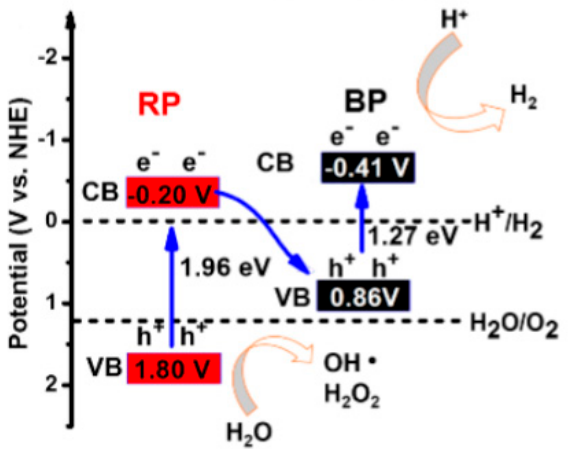
Figure 16. Schematic illustration of direct Z-scheme charge transfer pathway [60]. Reprinted with permission from ref. [60].